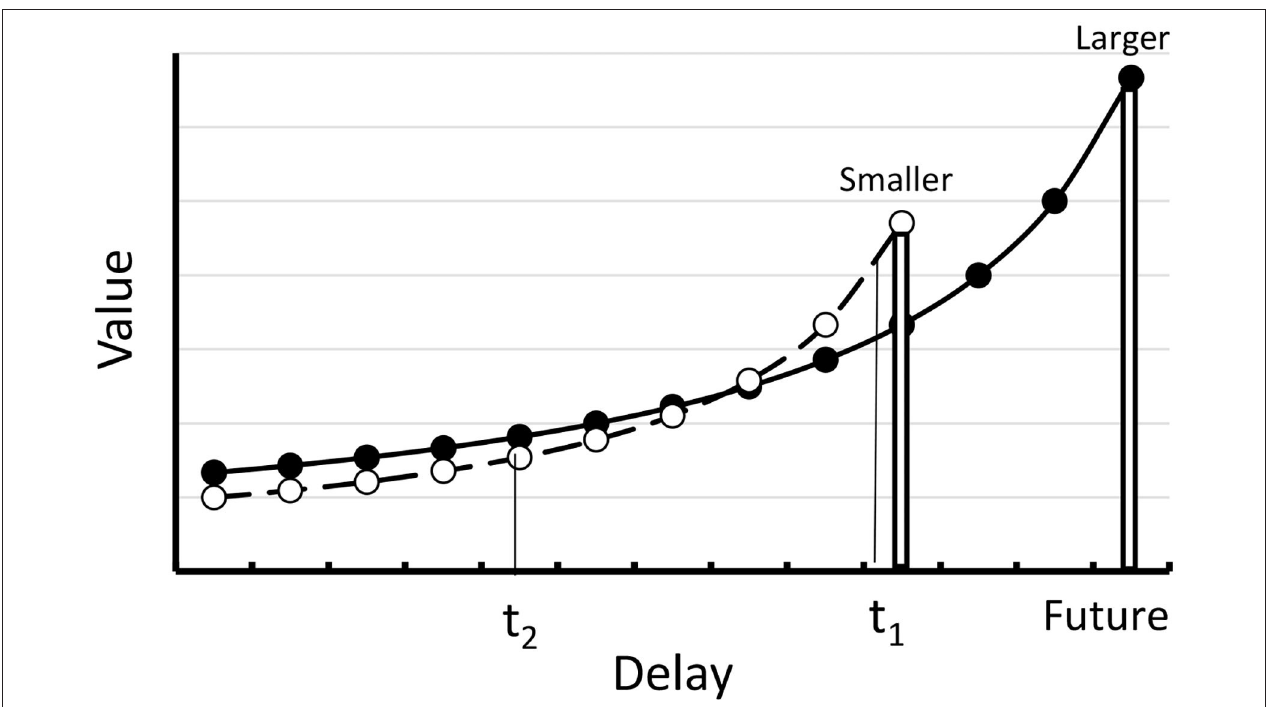
FIGURE 3 | Hyperbolic delay discounting function. At time 1 (t 1 ) the value of the smaller reward is greater than the value of the larger reward. At time 2 (t 2 ) there is a reversal of